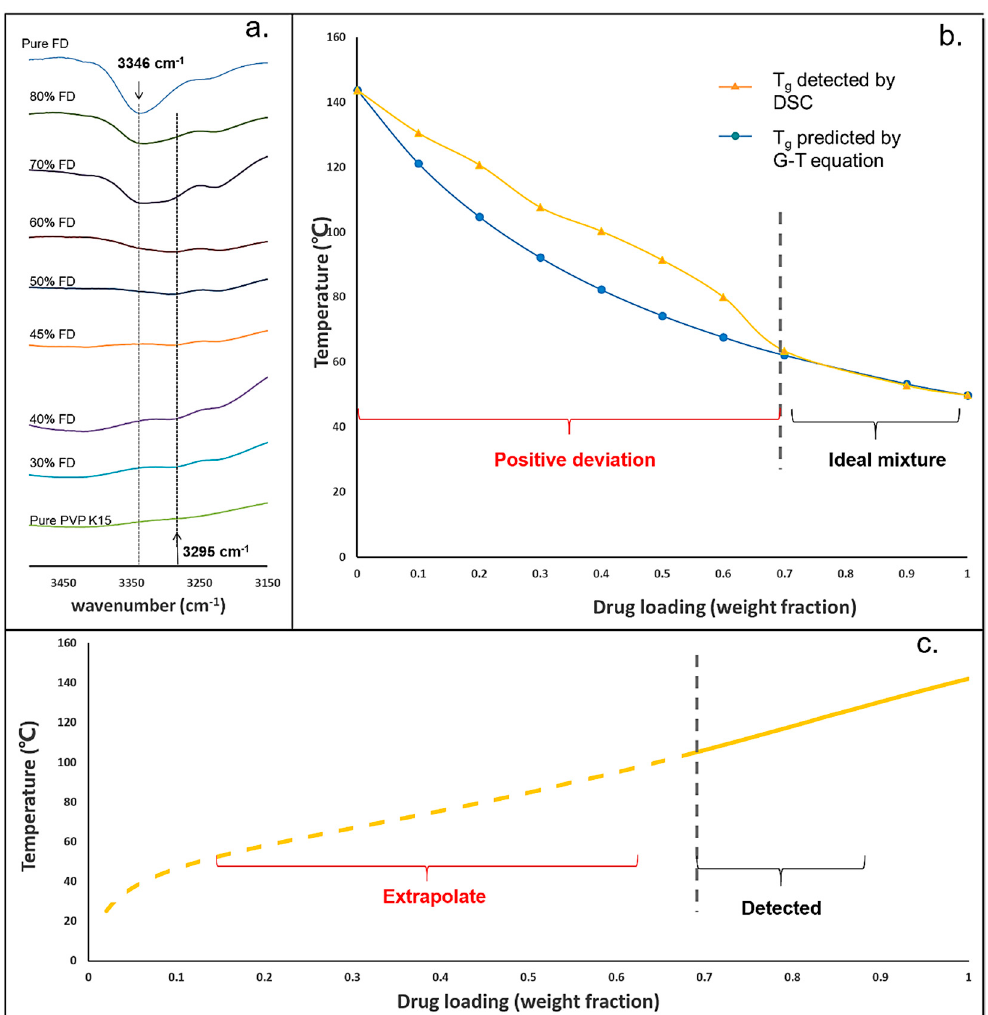
Figure 3. ( a ) The selected Infrared spectra of aFD-PVPK15 containing FD from range 0% to 100% (from top to bottom); ( b ) The yellow line represents the values of T g of aFD and PVPK15 ASDs measured by DSC, the blue line represents the T g s predicted by the Gordon-Taylor equation (ideal solution) ( n = 3); ( c ) The solubility line of system aFD and PVPK15 predicted using dissolution / melting depression data